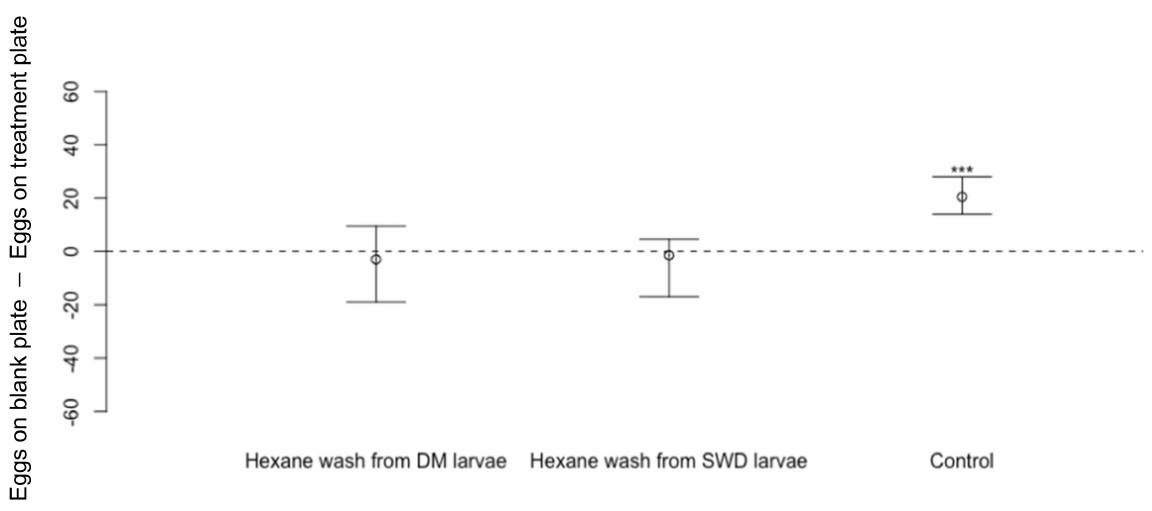
Figure 8. Differences in numbers of eggs laid by Drosophila suzukii (Median ± 95% confidence intervals) on cornmeal media dishes treated by hexane washes from larvae of D. melanogaster (DM) ( n = 12, p = 0.62) or D. suzukii ( n = 12, p = 0.54) compared to eggs laid on blank cornmeal media dishes treated only with hexane). In the control experiment, D. suzukii laid fewer eggs on cornmeal media dishes pre-exposed to D. melanogaster for 48 h beforehand ( n = 12, p < 0.001